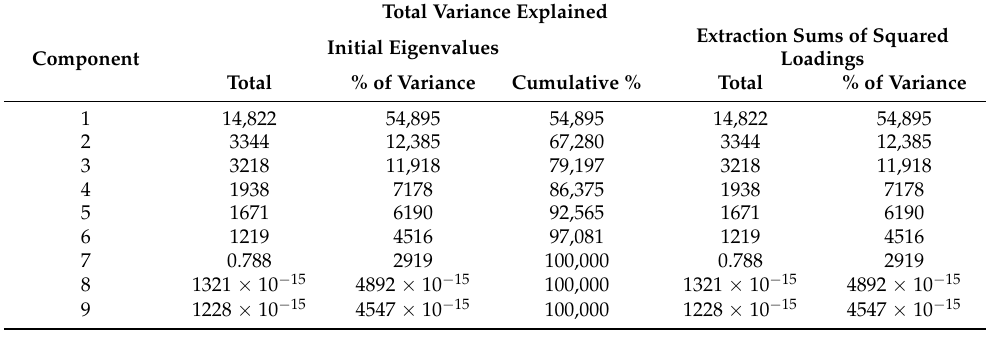
Table 7. Variance distributed in components (factors) using SPSS.